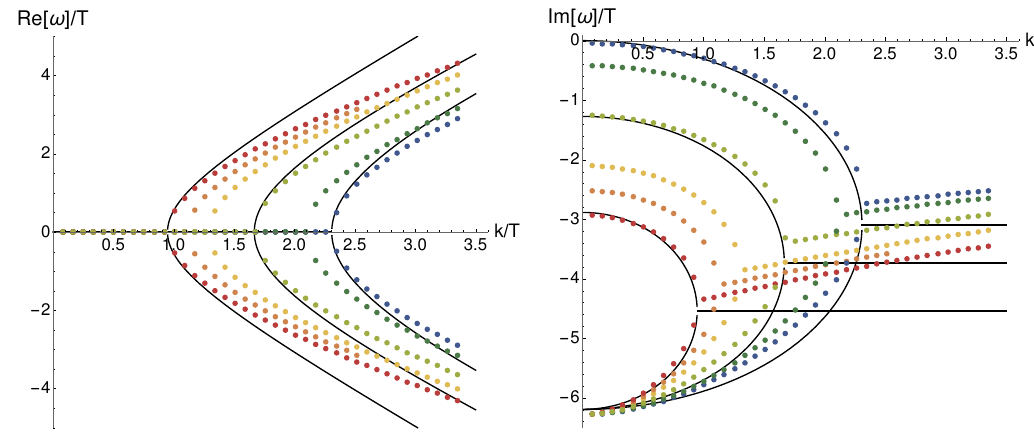
Figure 3 . Real and imaginary parts of the lowest modes with (cid:21) [0 : 01 (cid:0) 0 : 7] (blue-red). The blacks lines show some (cid:12)ts using formula (3.6). The dispersion relations show the appearance of a propagating mode above a certain momentum k (cid:17) k g typical of the k -gap phenomenon. where (cid:0) is the damping of the pseudo-di(cid:11)usive mode and c the asymptotic speed of P